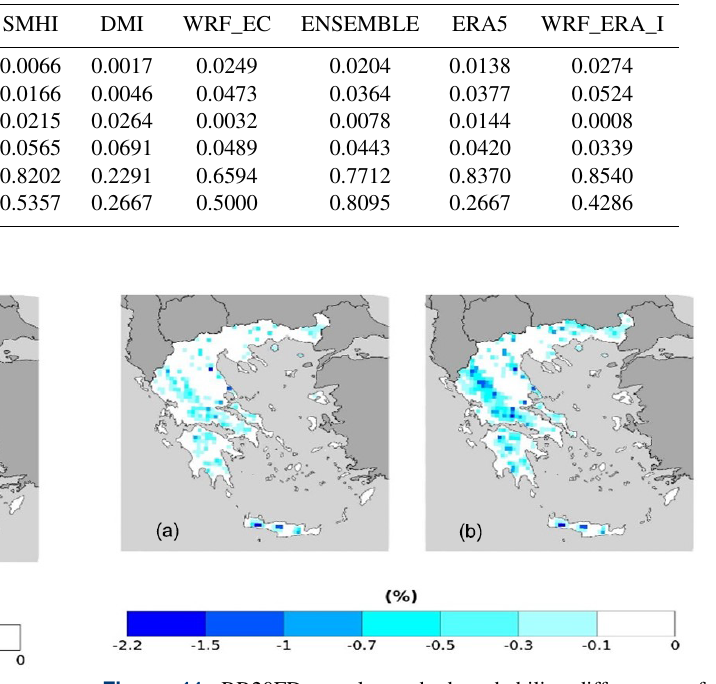
Figure 11. RR20FD copula method probability differences of future–past periods for (a) RCP4.5 and (b) RCP8.5